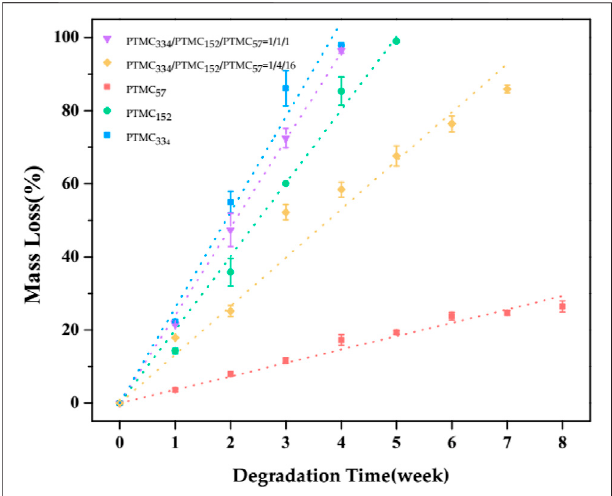
FIGURE 1 | The mass loss of PTMC fi lms and the ternary self-blending fi lms as a function of degradation